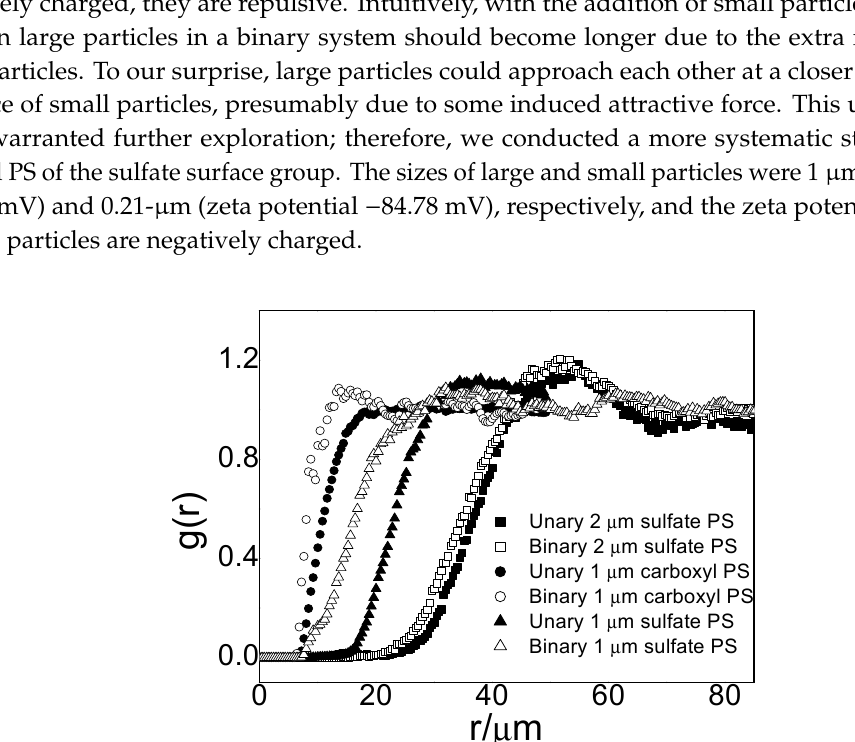
Figure 1. General method flow chart for measuring interaction potentials of colloidal monolayer and binary mixtures at the oil–water interface by recording images of interfacial particle monolayer, locating the particle via image processing, and calculating interactions between interfacial colloidal particles.